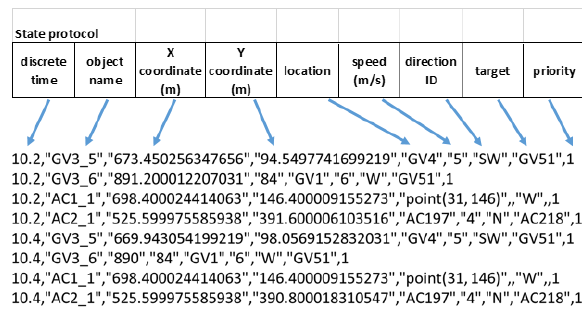
Figure 4. Fragment of a State Protocol file demonstrates